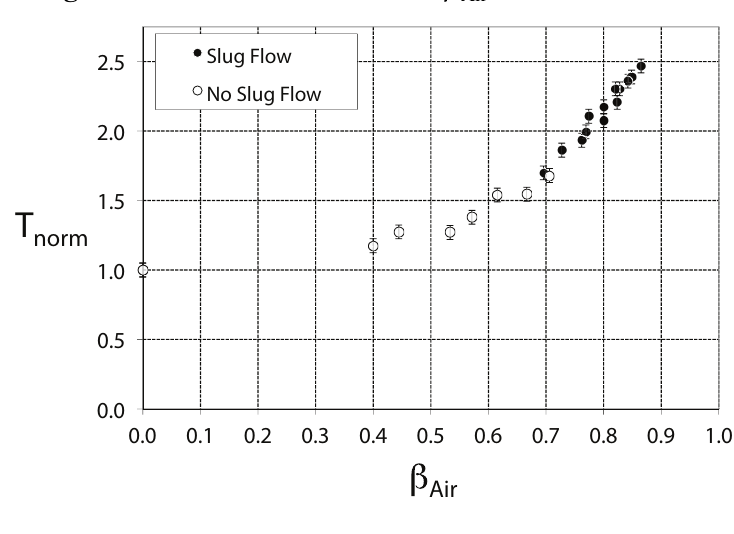
Figure 11. Normalized thrust vs. (cid:12)